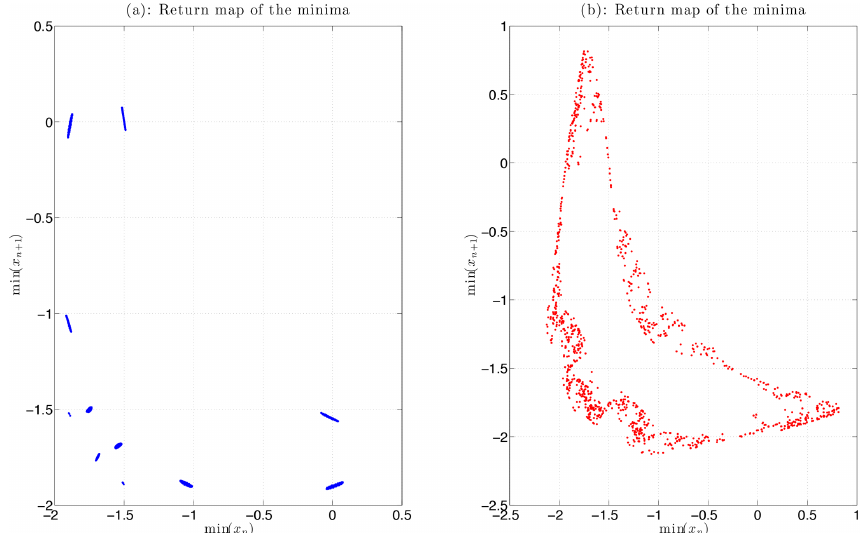
Figure A3. Return maps of the minima of x(t) for (a) the quasiperiodic orbit shown in blue in Fig. A1(a), and for (b) the chaotic orbit shown in red in Fig. A1a; see text for